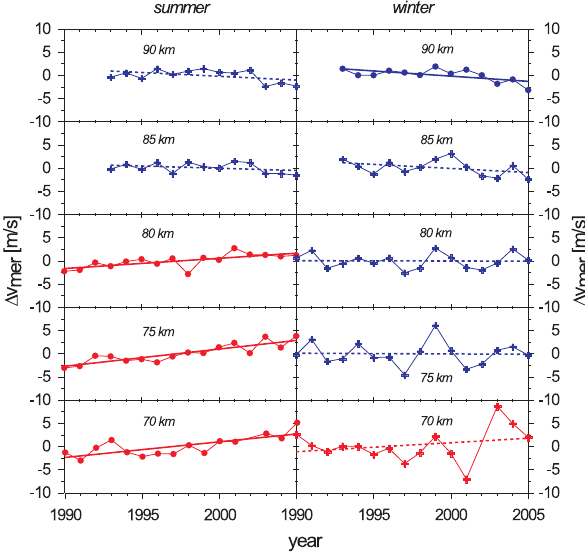
Fig. 15. Trend of the mesospheric zonal wind at Juliusruh after elimination of the solar activity induced parts for summer and win- ter conditions at different heights. Positive trends are red, negative trends blue. Significance levels are characterized by full lines and dots ( χ ≥ 95%), nonsignificant levels by dashed lines and crosses ( χ< 90%).